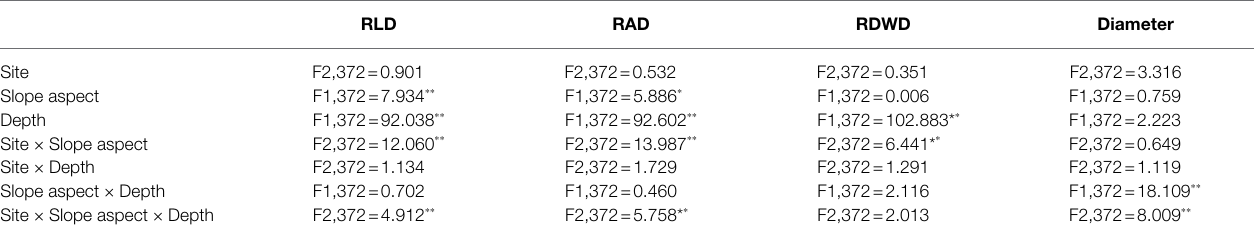
TABLE 4 | F-values for the effects of site, slope aspect, and depth, and the interactions between site × slope aspect, site × depth, slope aspect × depth, and site × slope aspect × depth based on fine root length density (RLD, m m − 3 ), fine root area density (RAD, m 2 m − 3 ), fine root dry weight density (RDWD. g m − 3 ), and fine root diameter (mm).